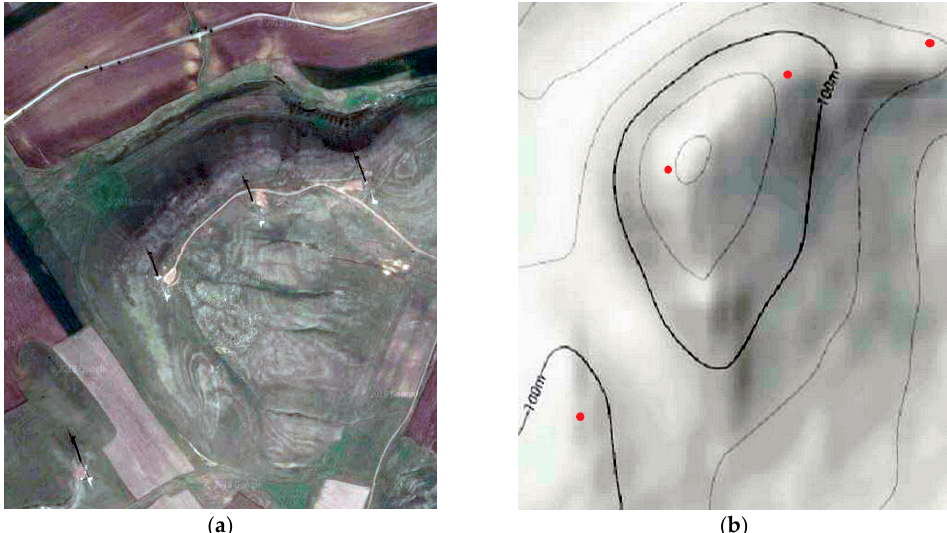
Figure 1. The layout and the contours of the quite complex hilly terrain (source: adapted from Google Maps). ( a ) The layout of the terrain (satellite view); ( b ) The contour of the terrain level (terrain view) and the positions of the turbines